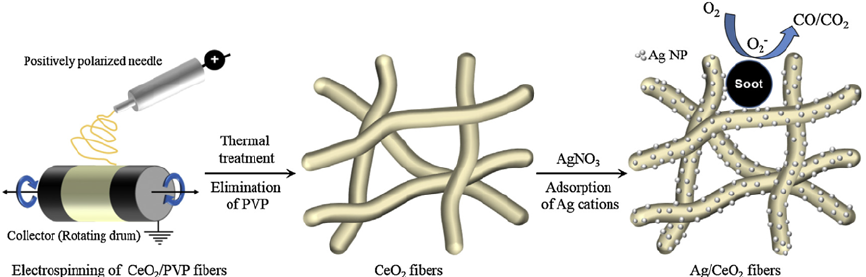
Figure 8. Schematic illustration of Ag/CeO 2 nanofiber synthesis sequence. CeO 2 nanofibers were fabricated through the electrospinning of spinnable Ce/PVP in a DMF/EtOH precursor solution followed by thermal treatment. Ag was then loaded on the surfaces of the CeO 2 nanofibers. Reproduced from Ref. [47] with the permission from the Elsevier.